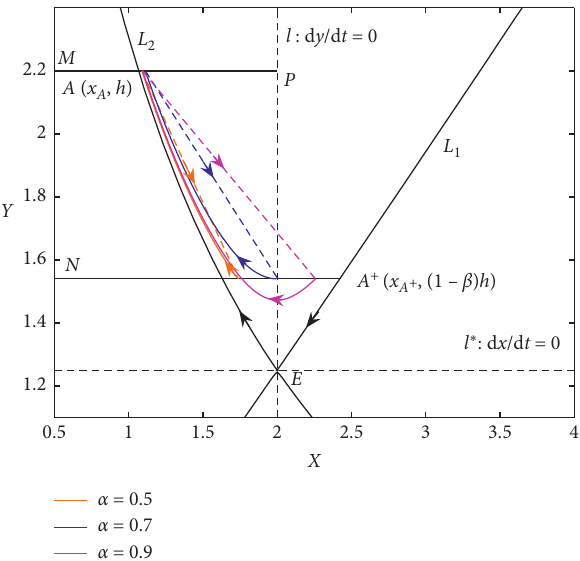
Figure 12: Existence of order-1 periodic solution when β � 0 . 3 with parameter values: a � 5 ,c � 4 , d � 6 , e � 3 , and h � 2 . 2 and initial values ( 3 . 5 , 2 . 4 ) . The cases of α � 0 . 5, α � 0 . 7, and α � 0 . 9 are shown with hazel, blue, and pink lines